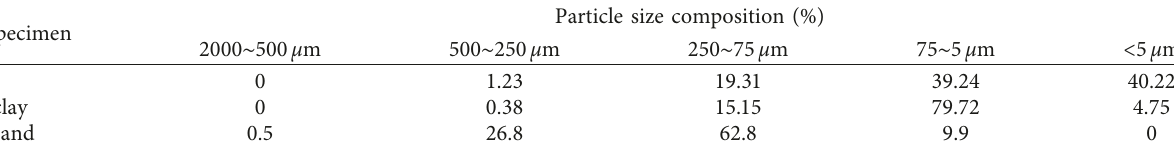
Table 5: Results of soil particle size analysis.